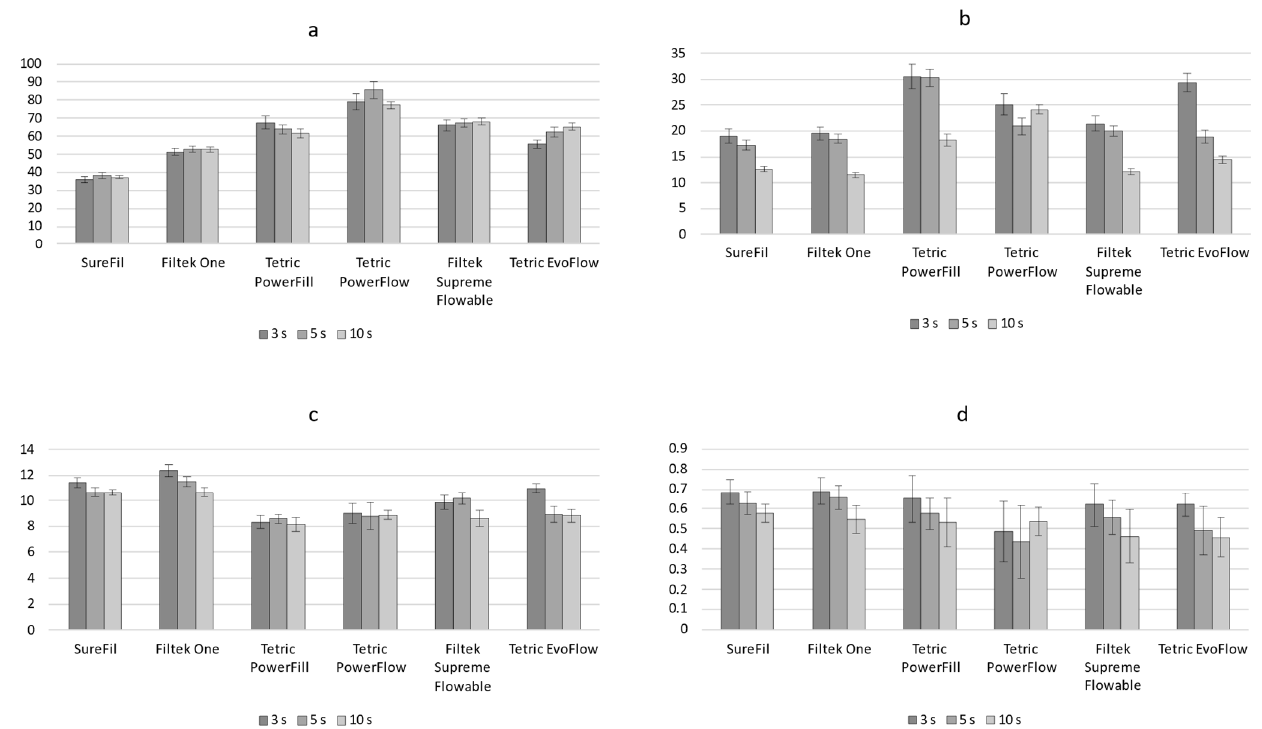
Figure 6. Fit parameters ( a – d ) of double exponential function used for describing polymerization kinetics. Error bars represent 95% confidence intervals.